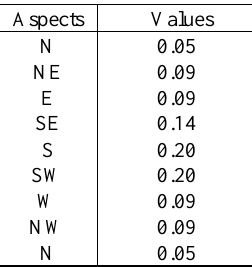
Table 14. The weighted values of the aspects The weighted averages of the criteria were combined and foret fire risk map was generated by using “extAhp 2.0” tool in ArcGIS 10.4.1. Table 15 shows the weighted average values of criteria assigned to forest fire risk map. The result indicated that the most effective criterion was tree species, followed by tree stages.